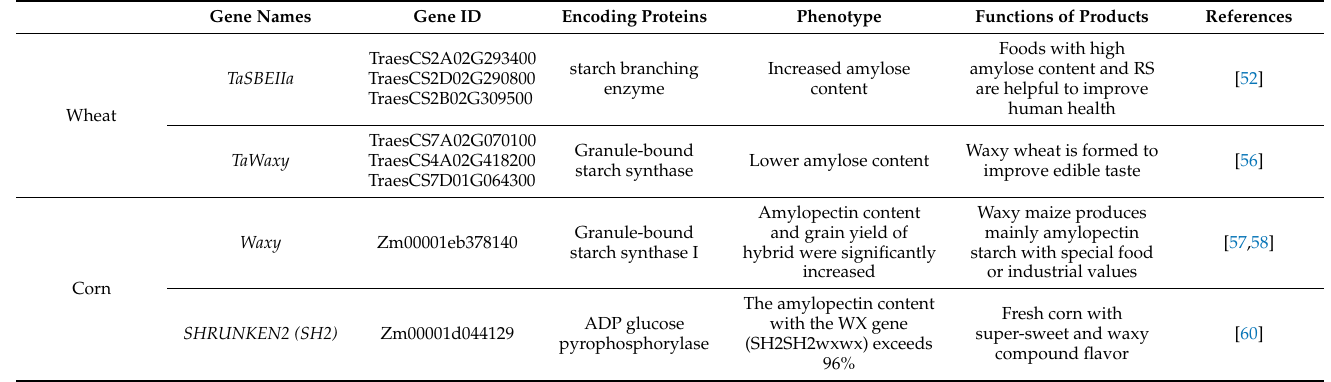
Table 1. Gene resources of starch biosynthesis and their applications to crop improvement using CRISPR/Cas9 gene